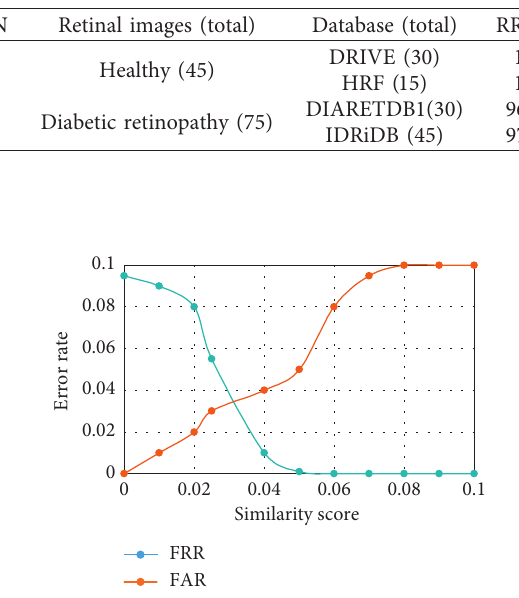
Table 4: Recognition rate of the developed recognition